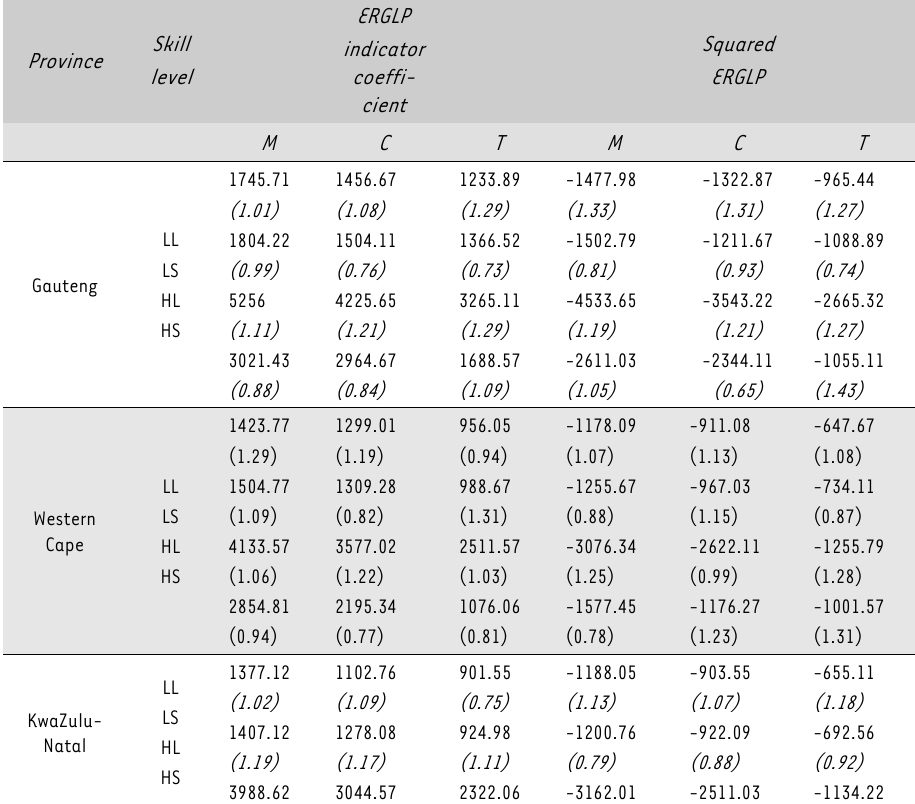
ERGLP indicator coefficients for the different industries in the different geographical areas when the different skill categories are included ERGLP Skill indicator Province level